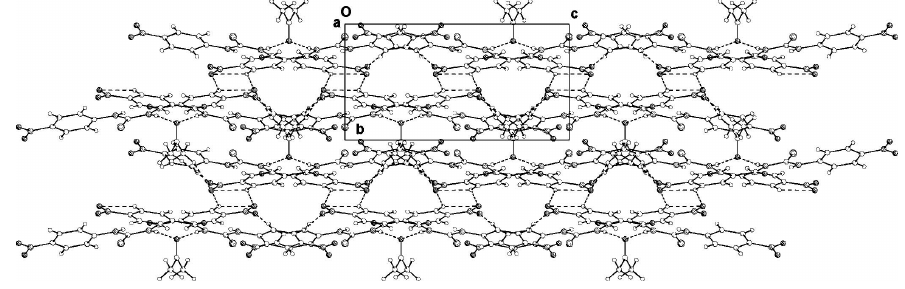
The molecular structure of the title compound. Displacement ellipsoids are drawn at the 30% probability level. Intramolecular hydrogen bonds are shown as dashed lines.